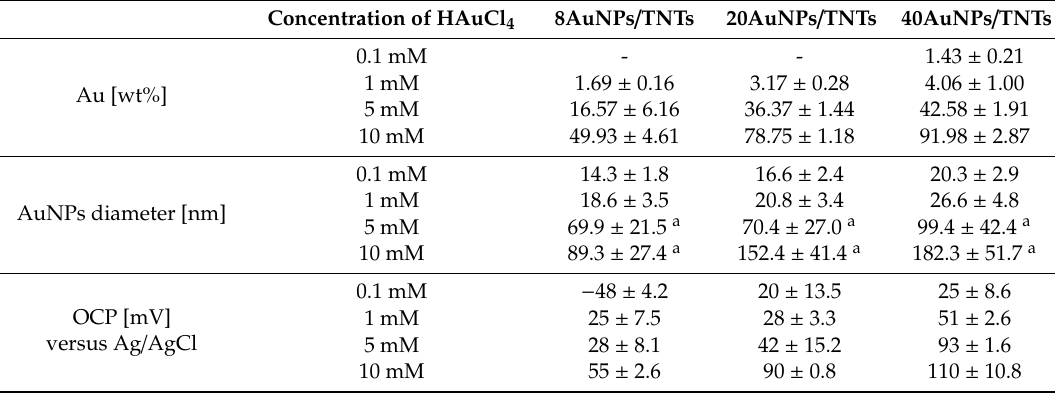
a —platform with